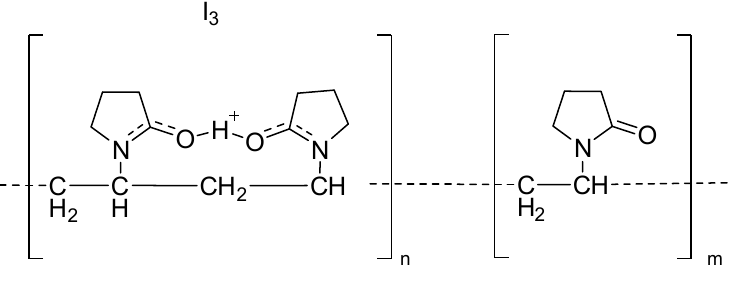
Figure 9. Structure of povidone-iodine complex.